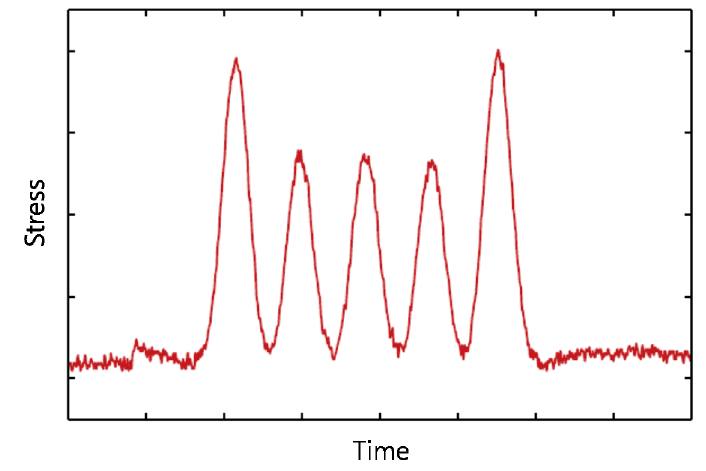
Figure 1. Generic stress response of a railway bridge under passing train.